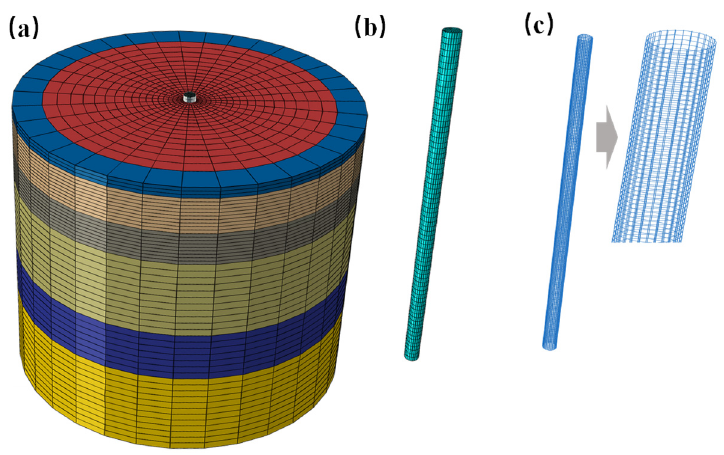
Figure 8. Finite element model of ( a ) soil foundation, ( b ) pile, and ( c ) reinforcement.